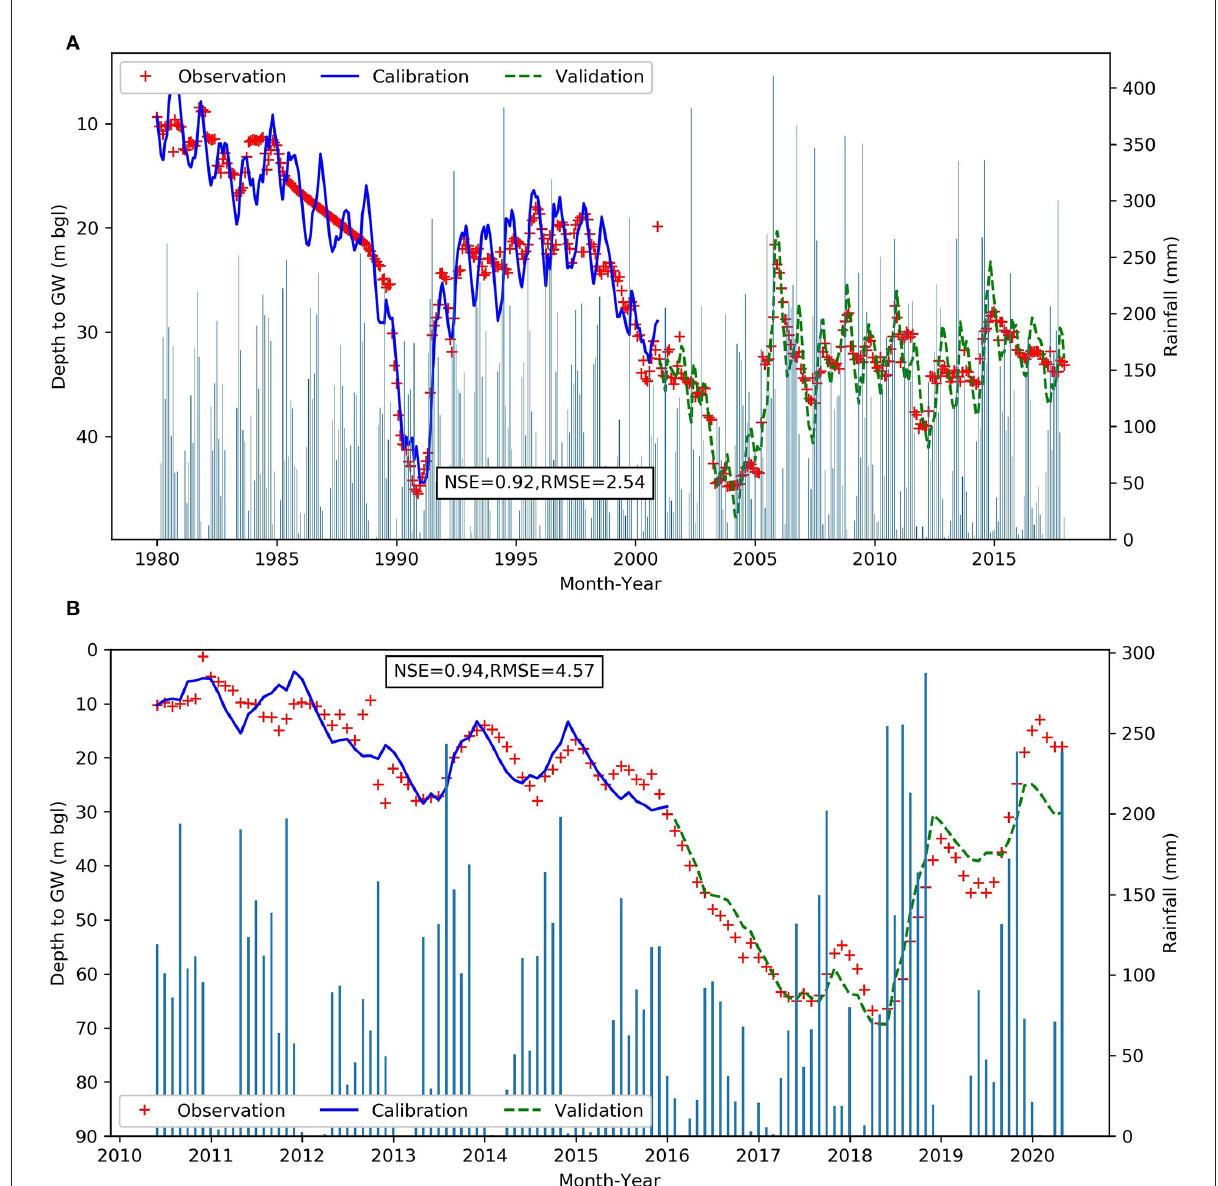
FIGURE3 Model calibration and validation for (A) OW#4 (Gundlupet town) in Gundlupet taluk and (B) B#149 in Berambadi EWS.